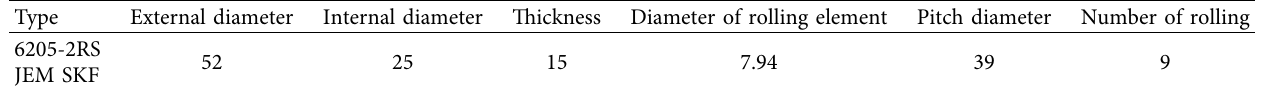
Figure 5: Bearing test ring. A : fan end bearing; B : electronic motor; C : drive end bearing; D : torque transducer; E : dynamometer. Table 1: Drive end bearing parameters (mm).